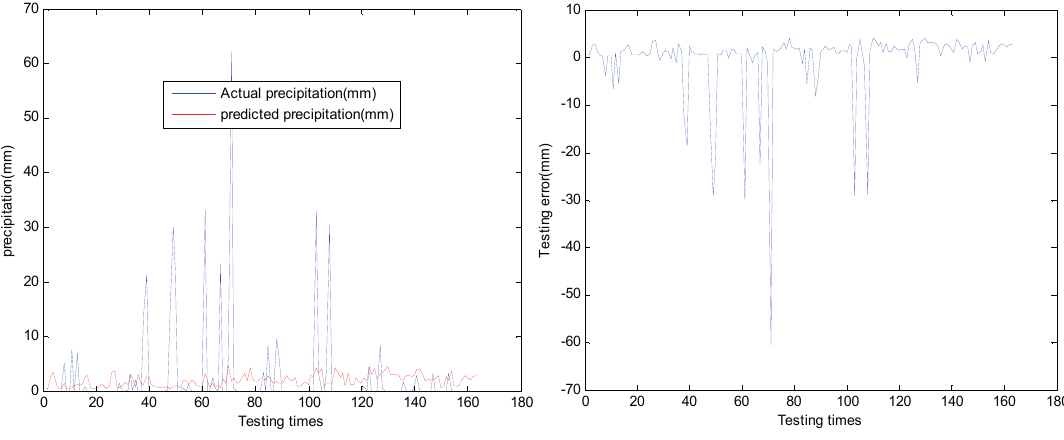
Figure 5. Testing results of artificial neural network (ANN).